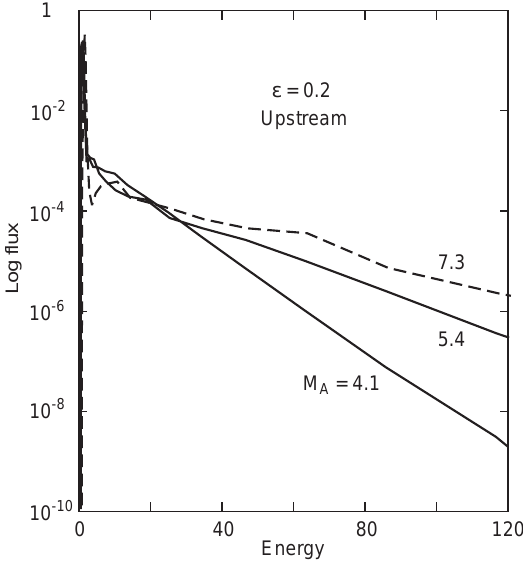
Fig. 5. The flux distribution upstream of a M A (cid:136) 5 : 4 shock with (cid:15) (cid:136) 0 : 2 for two di(cid:128)erent simulation box sizes, L (cid:136) 2000 c = x pi and L (cid:136) 4000 c = x pi